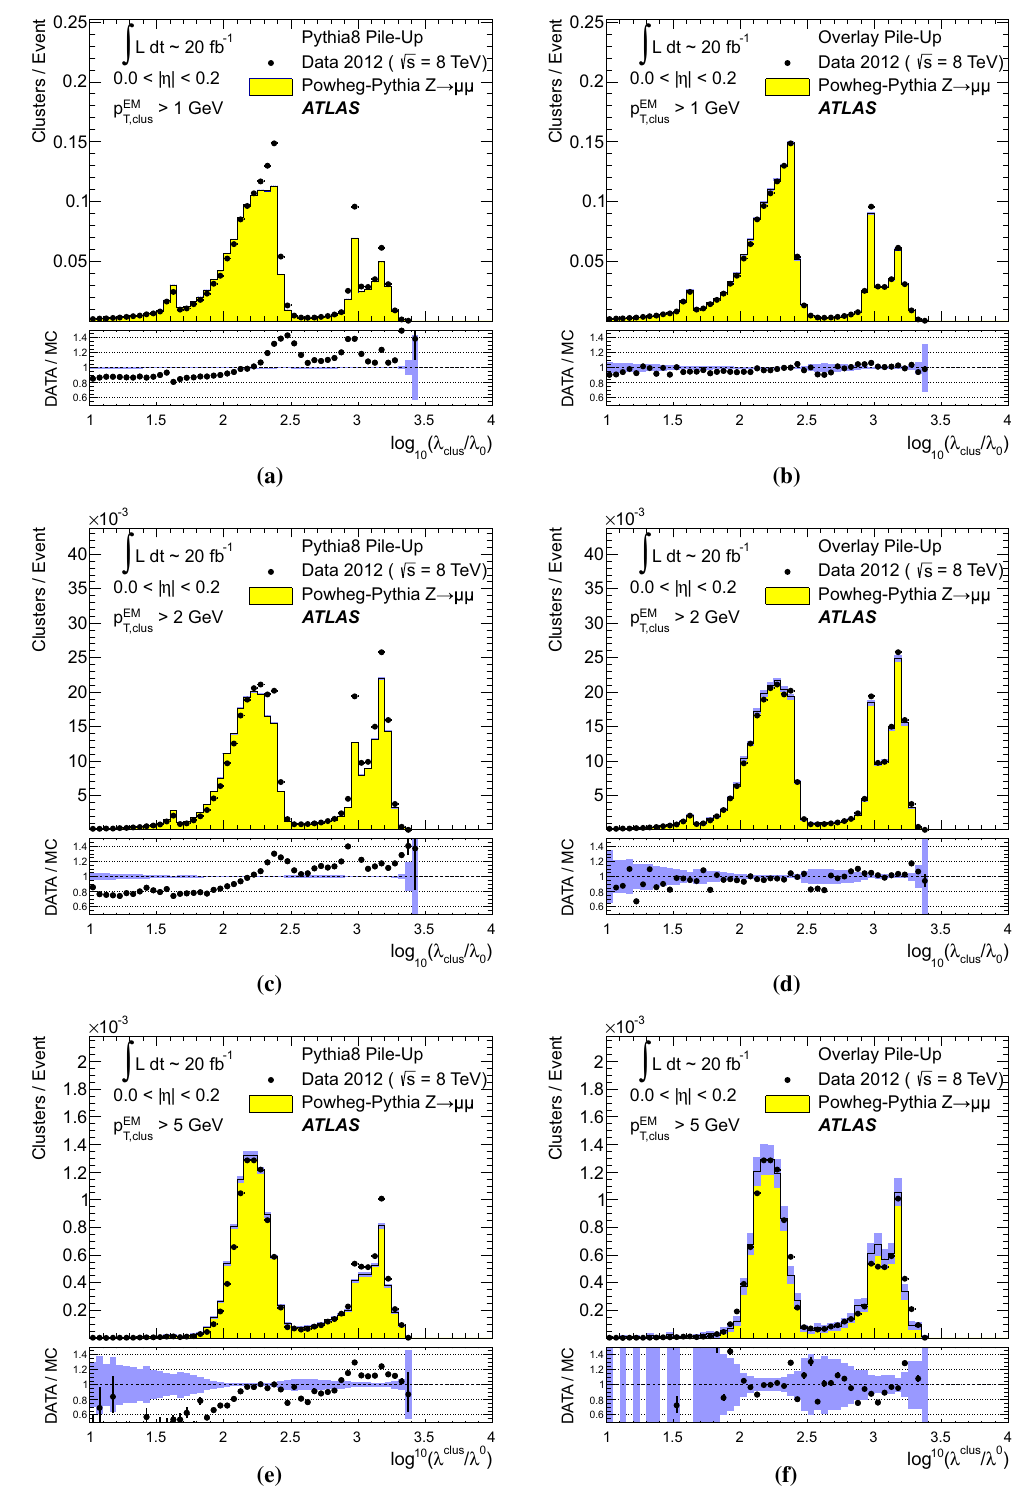
> 1GeV, c p EM > 2GeV, and e Fig. 29 Thedistributionofthetopo-clusterdepthlocation,measuredin all topo-clusters with a p EM T , clus T , clus terms of log 10 (λ clus /λ 0 ) , for selected topo-clusters within | η clus | < 0 . 2 > 5GeV. The corresponding distributions for MC simulations p EM T , clus and with a transverse momentum p EM , evaluated on the EM scale, with pile-up from data overlaid are depicted in b , d , and f . The shaded T , clus larger than various thresholds. Results are shown for an inclusive bands indicate the statistical uncertainties for the distributions obtained Z → μμ event sample recorded in 2012. Data are compared to dis- from MC simulations and the corresponding uncertainties in the ratio tributions from MC simulations including fully simulated pile-up for